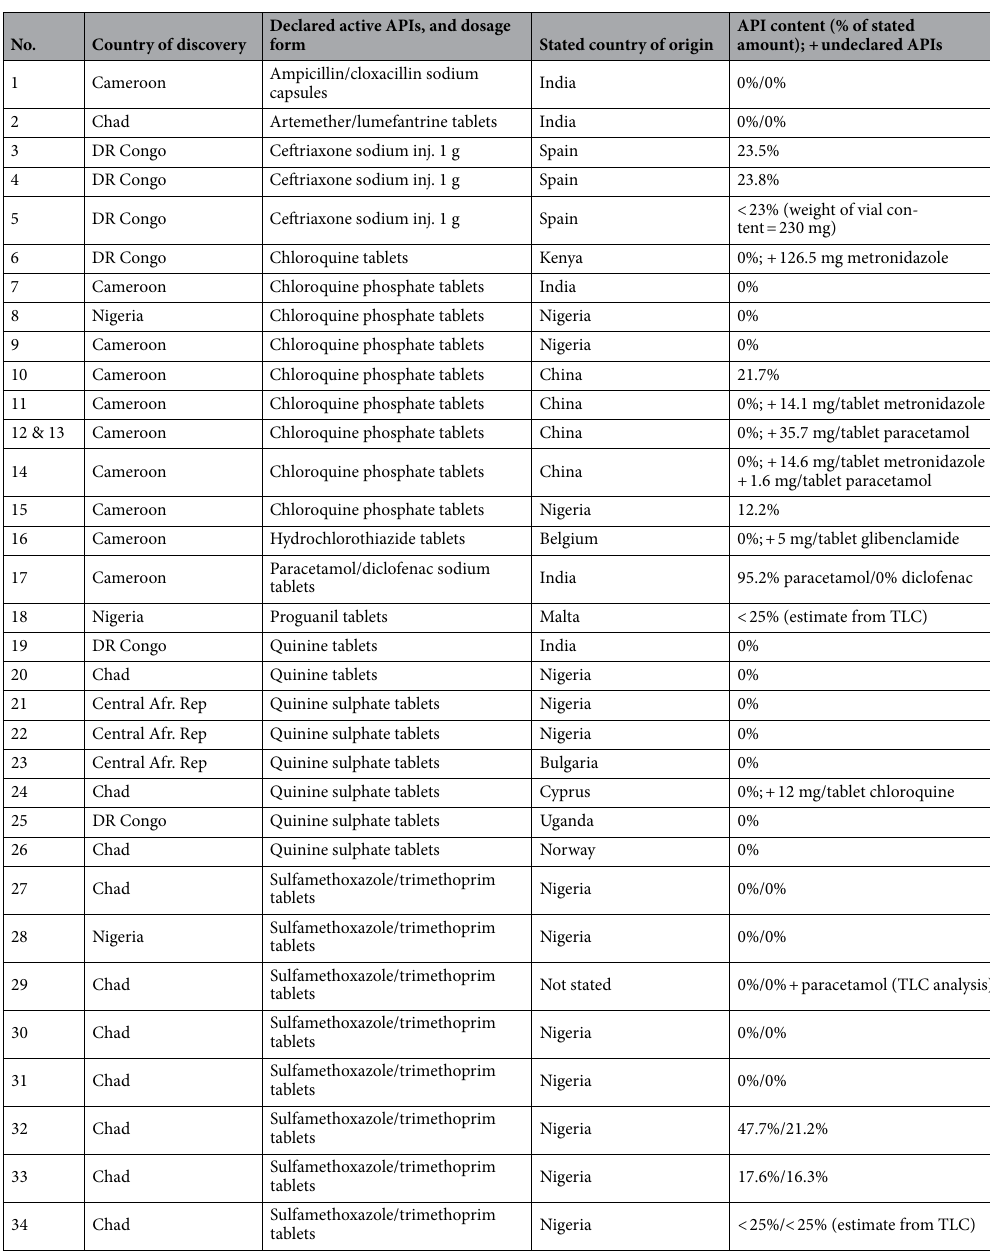
Table 2. Medicine samples identified in this study as probably falsified. In the cases 12 and 13, two samples of this medicine were identified independently in the course of this study. Supplementary Table S2 provides further details on these samples, including the brand names of the products, batch numbers, expiry dates and names of the stated